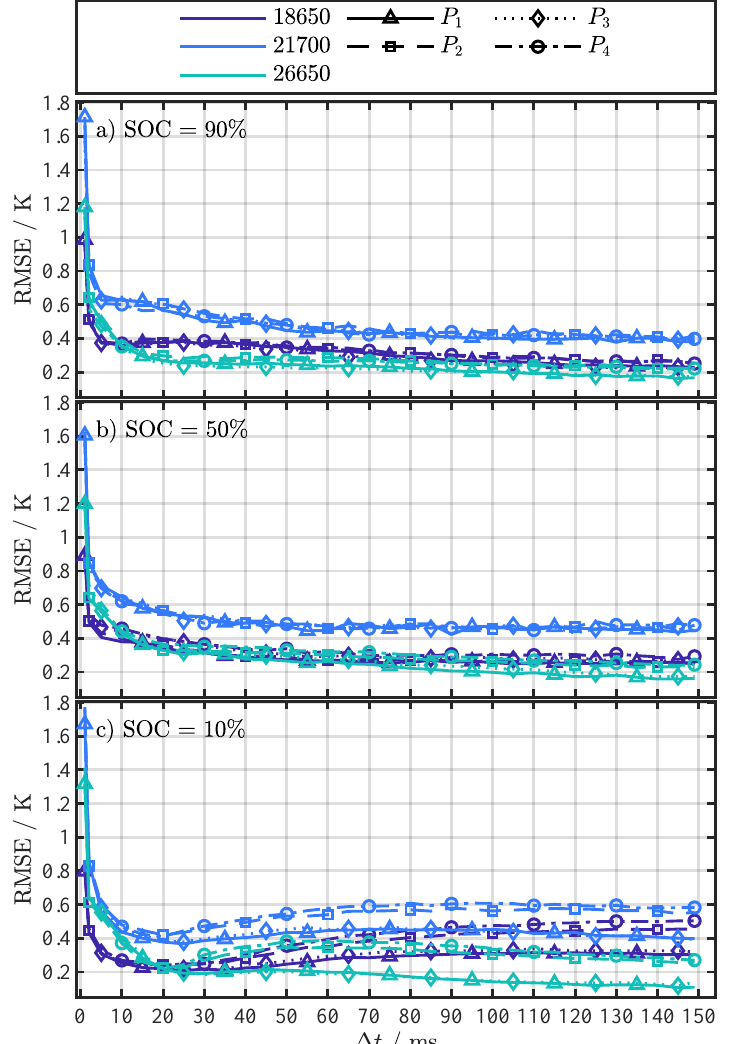
Figure A6. RMSE results for fitting Equation (4) for each investigated cell format and the four different pulse current types ( P 1 to P 4 ) at the SOCs 90% ( a ), 50% ( b ), and 10% ( c